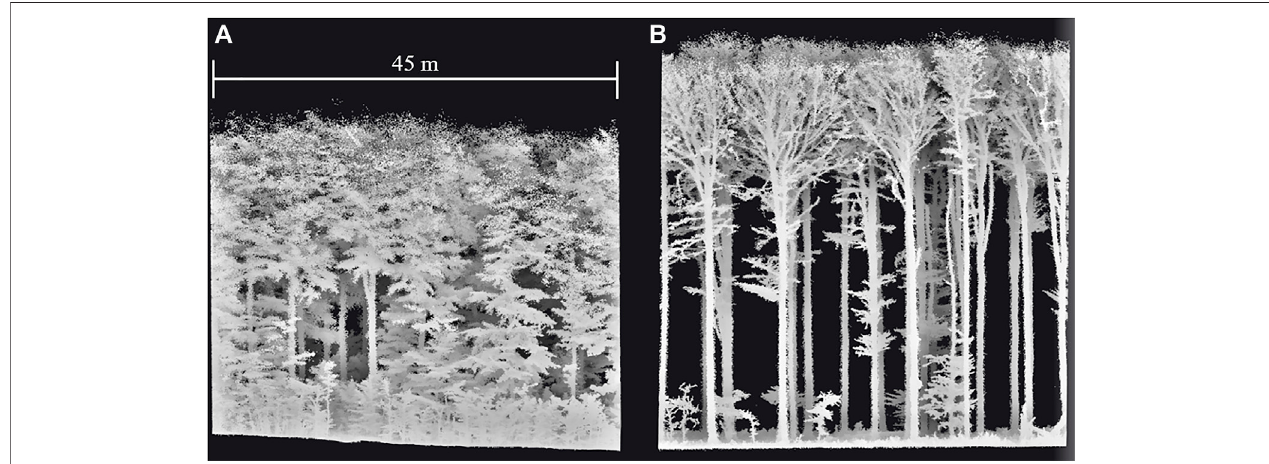
FIGURE 3 | Point clouds (45 × 45 m plot area) from the mobile laser scanning in Cloud Compare. (A) From one uneven-aged managed study plot in Göttingen during August with an age of the most dominant trees of 148 years and (B) from the even-aged formerly managed forest stand in Oppershofen in February, during full defoliation with a tree age of 162 years, which is unmanaged since 1988. Figures are in scale.